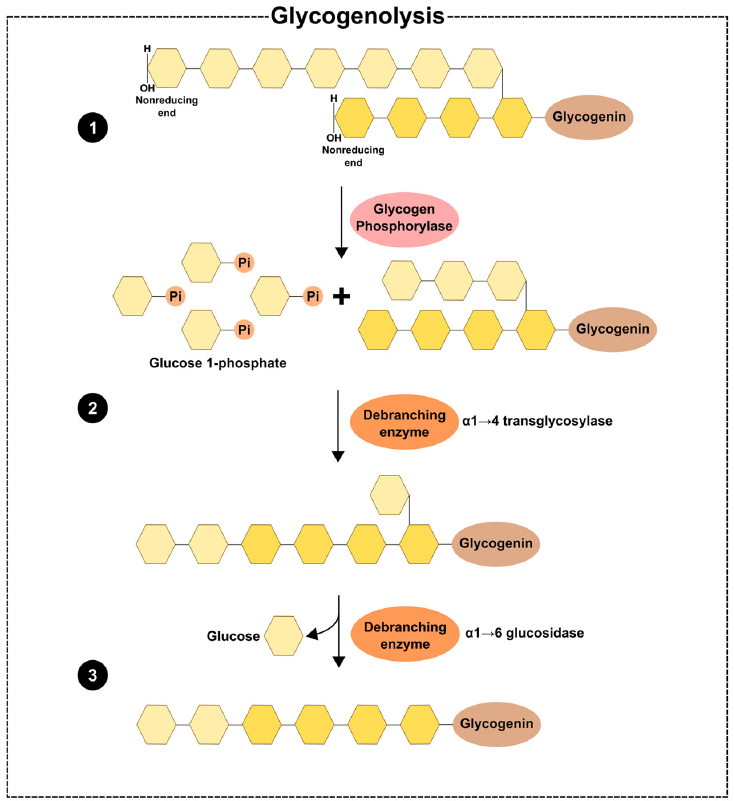
Figure 2. Schematic illustration of the degradation of glycogen in the cytosol: (1) the degradation starts with the phosphorolysis of the ( α‐ 1 → 4) glycosidic bonds by glycogen phosphorylase, releas ‐ ing glucose ‐ 1 ‐ phosphate, until four glucose residues remain at a branch point. The glycogen de ‐ branching enzyme has two activities; (2) the transferase activity catalyses the movement of three residues of glucose from a lateral to a linear chain; (3) the α‐ 1,6 ‐ glucosidase activity hydrolyses the ( α‐ 1 → 6) linkages, releasing glucose. 3. Glycogen in the Testicular Environment The testes have two important functions: the production of mature sperm (spermat ‐ ogenesis) and the synthesis of steroid hormones (steroidogenesis). The action of Sertoli, Leydig, and germ cells must be coordinated to accomplish all these events. The metabolic cooperation established within these cells is fundamental to supporting the energy needs for spermatogenesis and steroidogenesis in the testis, although the particular role of gly ‐ cogen in this event is far from being fully elucidated (Figure 3).